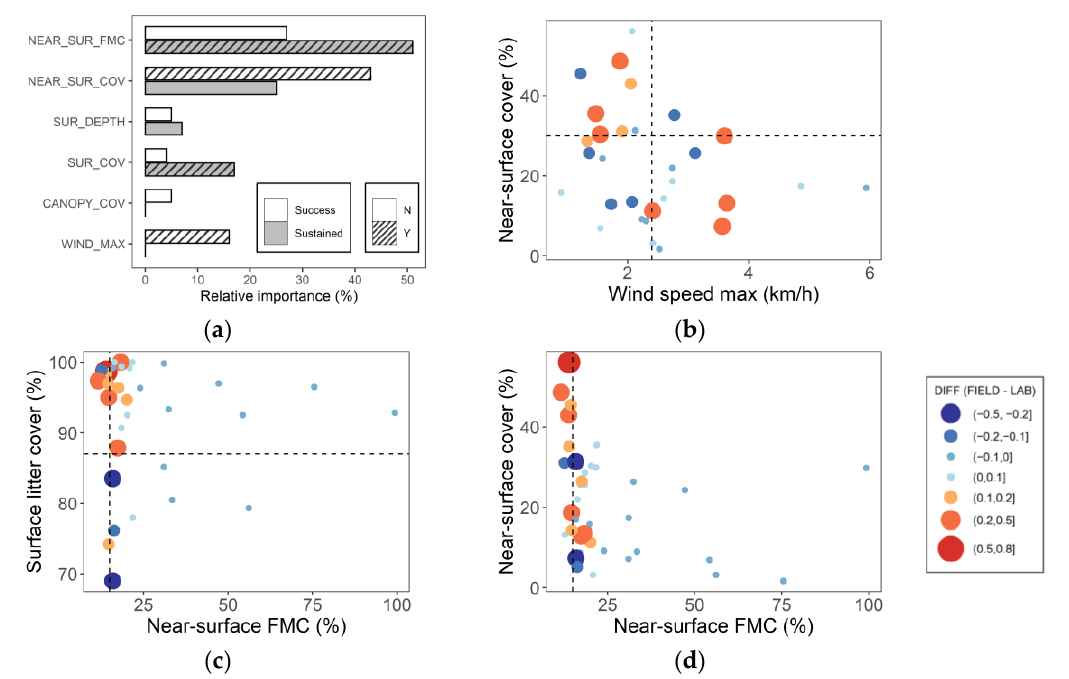
Figure 5. ( a ) Relative importance of predictors to the difference between the laboratory and field results for successful and sustained ignitions; hashed lines represent significant predictors (splits); ( b ) scatterplot of near-surface fuel cover and wind speed for successful ignitions; ( c ) scatterplot of near-surface fuel moisture and surface litter cover for sustained ignitions; ( d ) scatterplot of near- surface fuel moisture and near-surface fuel cover for sustained ignitions. Colours and size of points in ( b – d ) represent size of the difference between field and laboratory results; positive values mean field result was greater than laboratory result (red: underestimation); negative values mean field result was less than laboratory result (blue: overestimation).